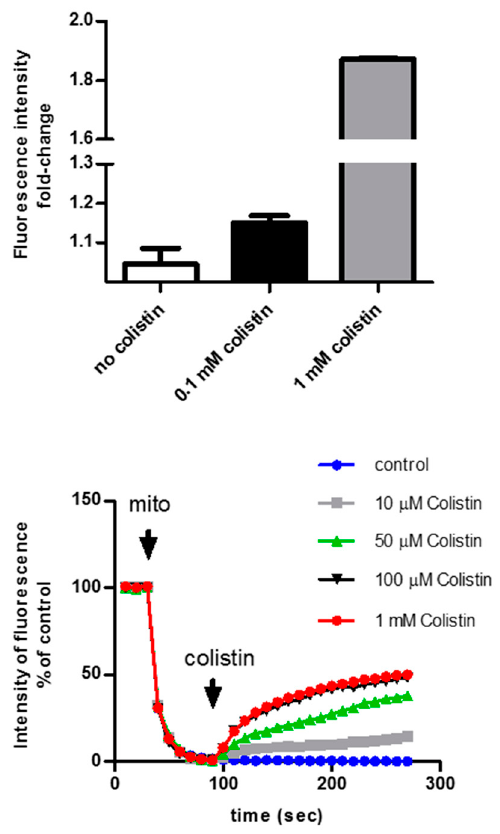
Figure 5. Effect of colistin on isolated mitochondria. Freshly isolated mitochondria from mouse kidneys were exposed to a hydrophilic Ca 2+ -sensitive dye: calcium release from the mitochondria results in an increase in the fluorescent signal (top panel). Mitochondria were exposed to rhodamine 123, a membrane potential-sensitive) dye. The lower the membrane potential, the higher the rhodamine 123 fluorescence signal ( λ ex = 488 nm, λ em = 527 nm) (bottom panel).